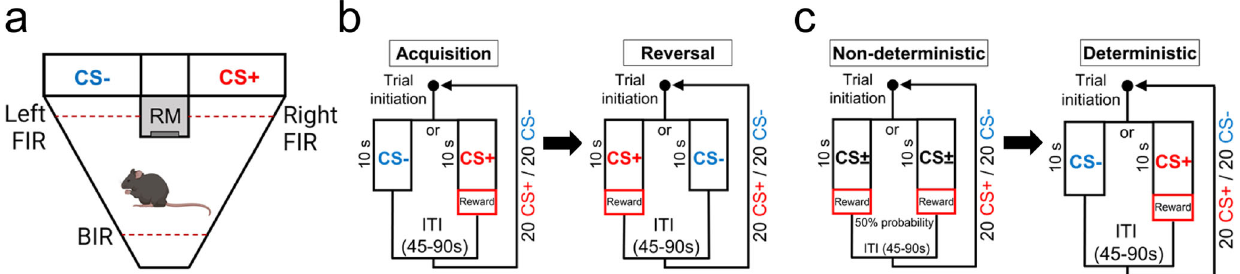
Fig. 1 | The touchscreen Autoshaping task to assess Pavlovian approach behaviours toward reward-predicting stimuli. a Layout of the Autoshaping touchscreen operant chamber depicting the two screens (left, CS-; right, CS+) and the reward magazine (RM) delivering strawberry milkshake reward (10 μ l). Each chamberwas equippedwith a backinfrared photobeam(BIR)to initiate trials, and two frontinfrared photobeams(FIR)oneach sideofthe RMto recordapproaches to the CS screen. An infrared photobeam inside the RM (not displayed) recorded latency time to collect rewards. b Flowchart overview of the Autoshaping task during acquisition (left) and reversal (right) training sessions. (left) Following a variable ITI, a trial initiated after breaking the BIR followed by the presentation of thestimulus(CS+orCS − )during10s.UponCS+offsetarewardwasdeliveredand a new ITI began once the mouse pulled away from the RM. Upon CS − offset, no